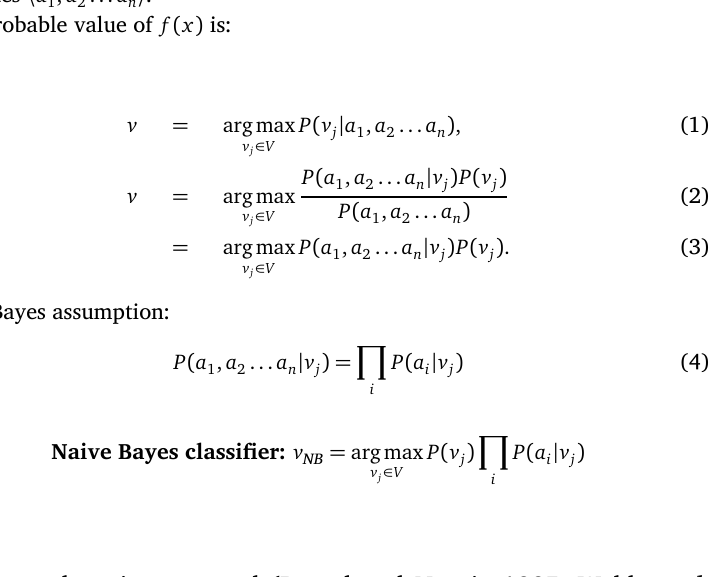
Figure 6: Naive Bayes